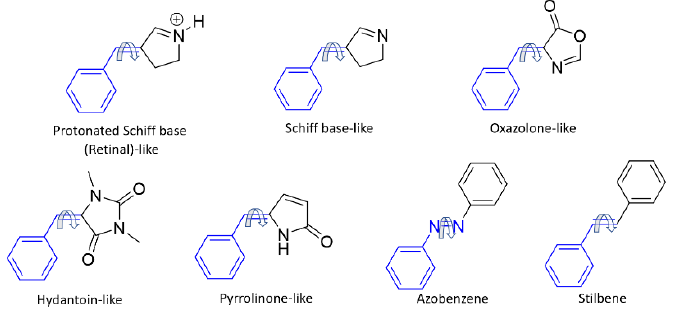
Figure 2. Photoswitches studied in this work. All of them have in common a benzylidene ring covalently linked to a rotatable C=C double bond, apart from azobenzene, which contains a rotatable N=N double bond (shown in blue). The most stable E isomers are represented.